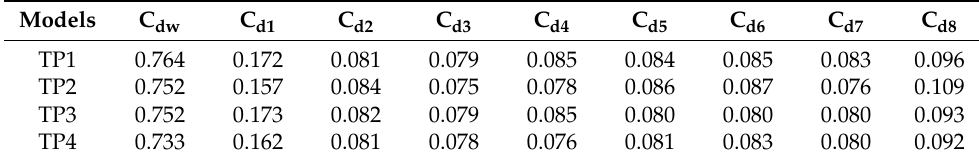
Table 3. Time-averaged Cd of the four models.